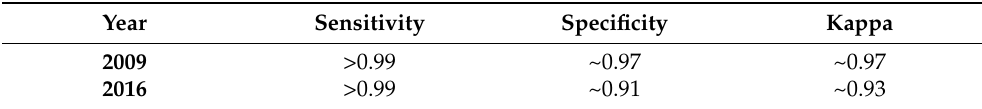
Figure 2. RapidEye coverage of the study area and manual digitization of reference data for the years 2009 (top) and 2016 (bottom). Table 1. Summary of parameters specifying the efficiency of the selected approach for classification of maize